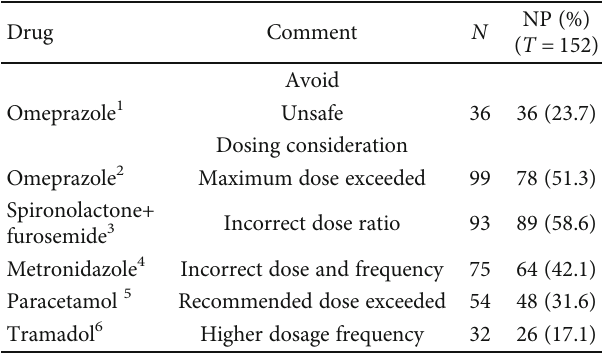
Table 5: Prescriptions not compliant with safety